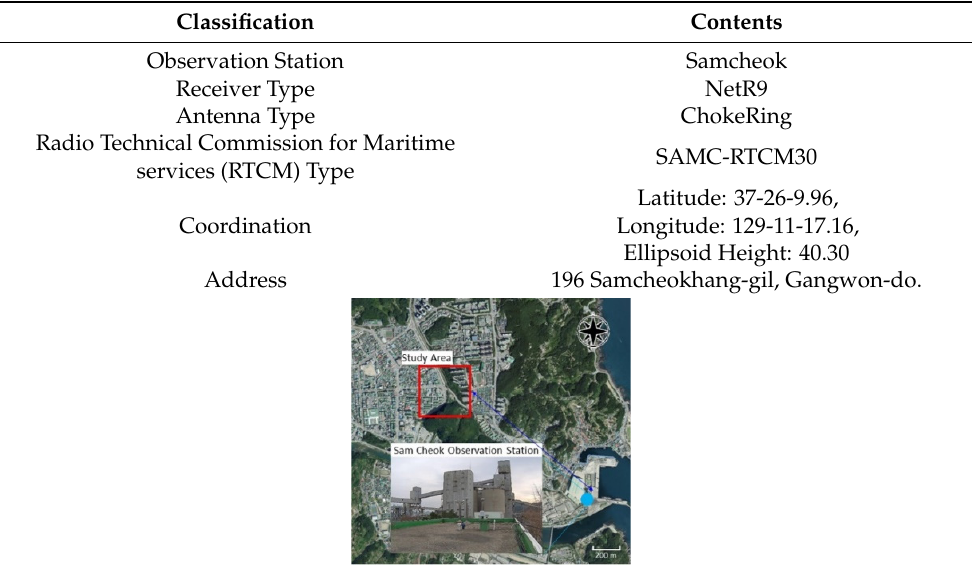
Table 4. Condition of the Global Navigation Satellite S ystems (GNSS) observation station.